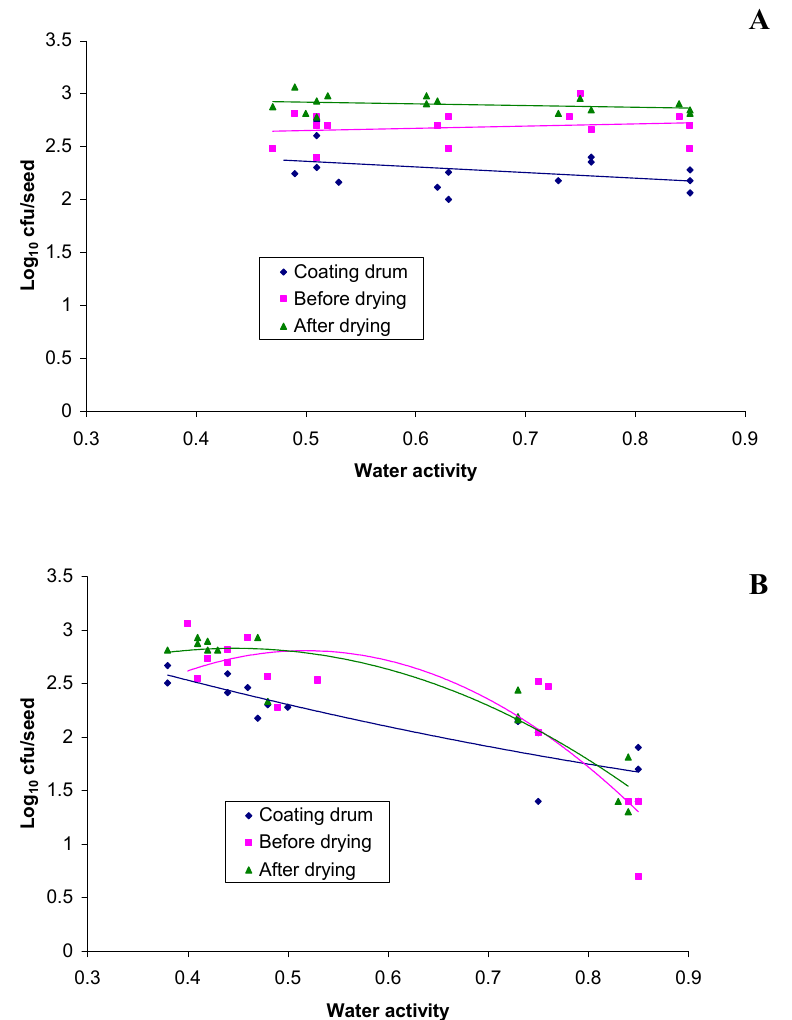
Figure 3. Survival of rhizobia on lucerne seed as a function of water activity after three ( A ) and nine ( B ) weeks storage at different relative humidities. ( A ) R 2 values: 0.1344 (coating drum), 0.0326 (before drying), 0.0845 (after drying). 2-way ANOVA: Seed batch P = <0.001, RH P = 0.418, Seed batch x RH P = 0.340; ( B ) R 2 values 0.7623 (coating drum), 0.7664 (before drying), 0.8756 (after drying). 2-way ANOVA: Seed batch P = 0.02, RH P = <0.001, Seed batch x RH P =